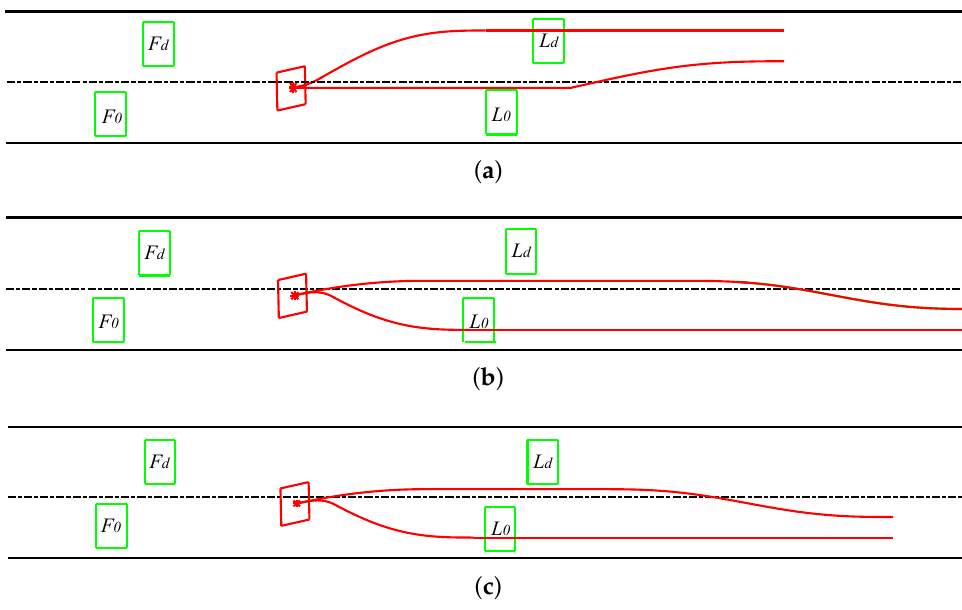
Figure 21. The driving envelope in double-lane traffic scenario. ( a ) The driving envelope of lane- change maneuver, v ego = v Fd = v F 0 = v Ld = v L 0 = 15 m/s. ( b ) The driving envelope of lane-change abortion maneuver, v ego = v Fd = v F 0 = v Ld = v L 0 = 15 m/s. ( c ) The driving envelope of lane-change abortion maneuver, v ego = v Fd = v F 0 = v L 0 = 15 m/s, v Ld =5